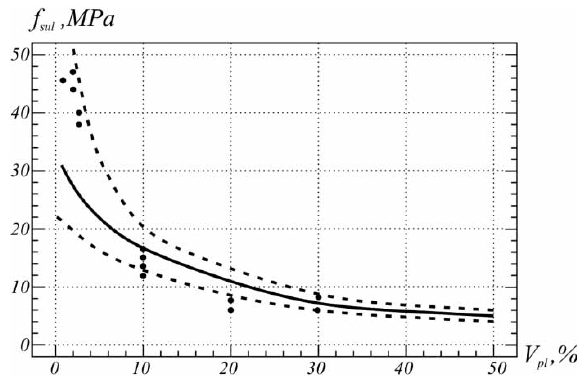
Fig. 1. Influence of plasticiser no. 1 on the compressive strength of sulphur